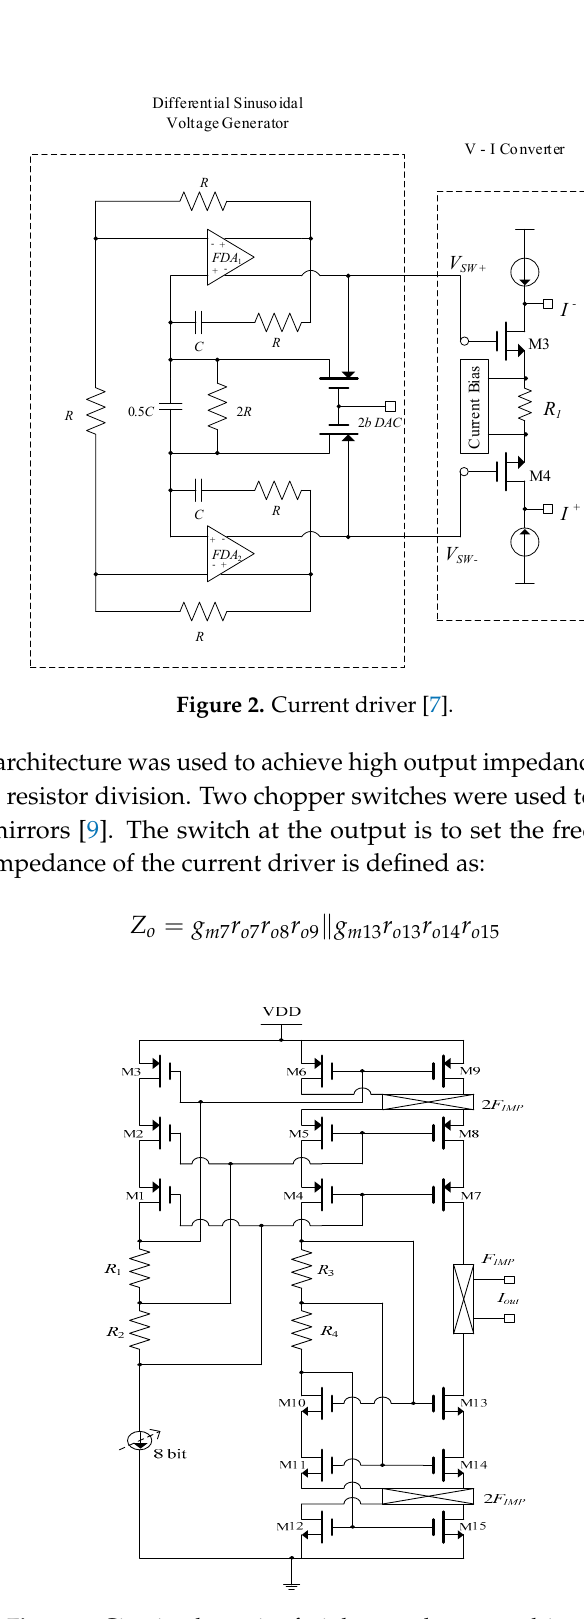
Figure 3. Circuit schematic of triple cascode current driver [9].